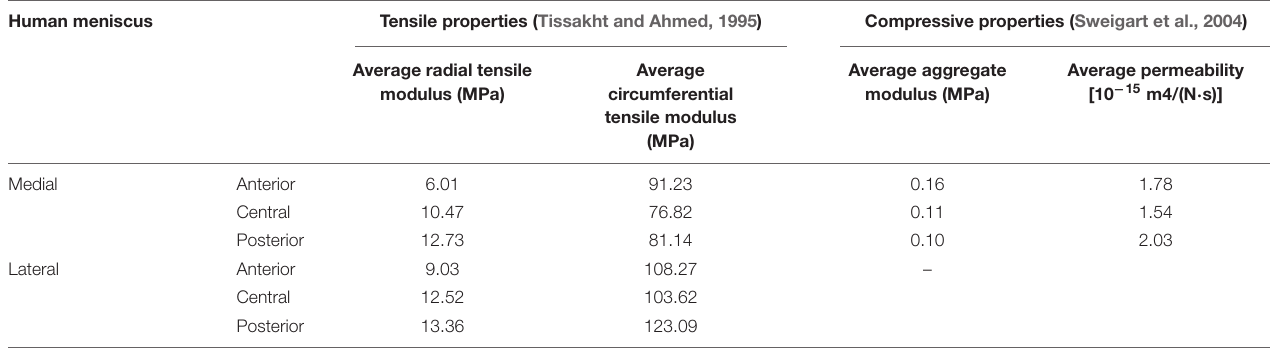
TABLE 1 | Native meniscal tissue physical characteristics. Human